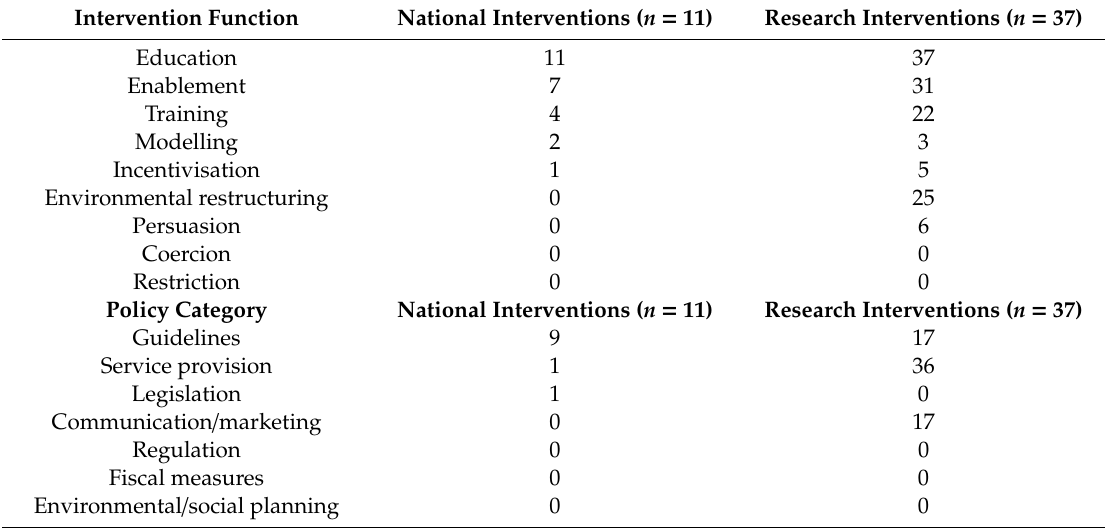
Table1. Frequencyofinterventionfunctionsandpolicycategoriesinnationalandresearchinterventions. Intervention Function